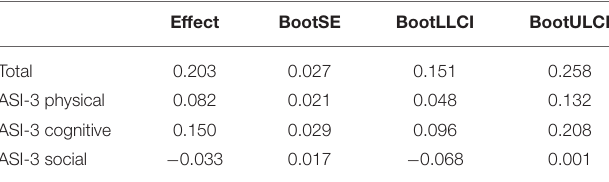
TABLE 6 | Analysis of the mediating effect of physical, cognitive, and social concerns on negative bias affecting